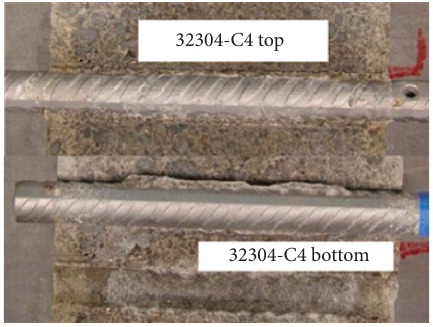
Figure 5: Visual examination after exposing rebar embedded in mortar specimens